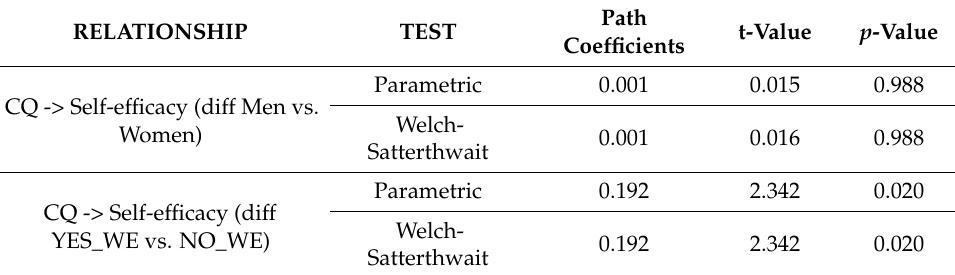
Table 5. Multigroup analysis (MGA)